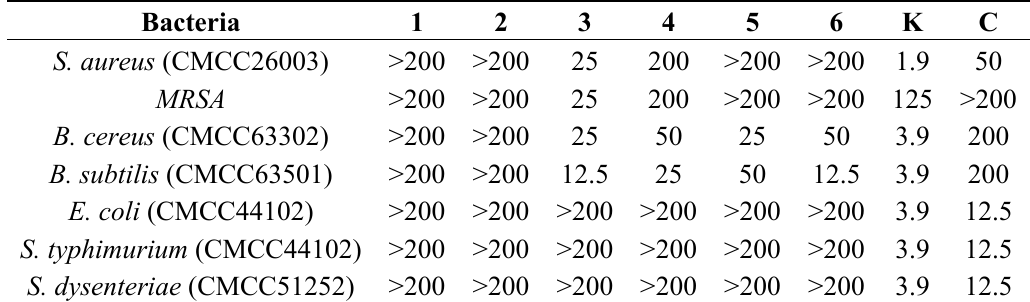
Table 2. MIC values of compounds 1 – 6 in μ g/mL against seven bacterial